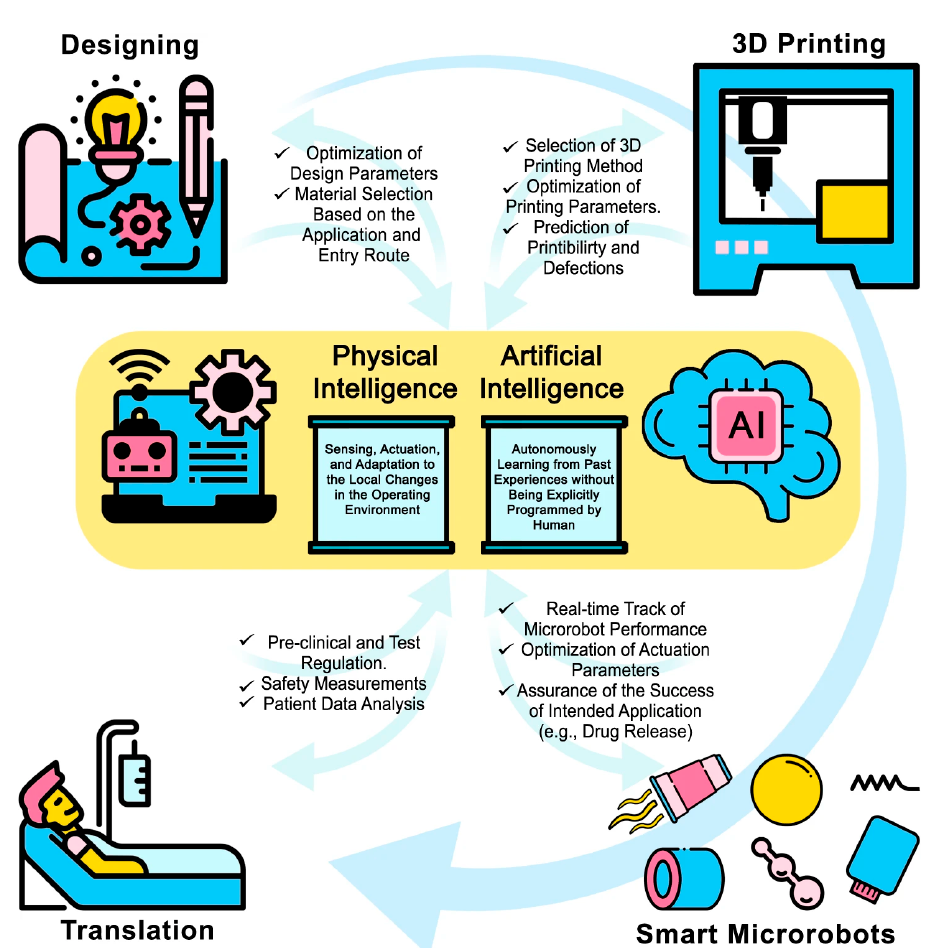
Figure 2. Proposed design of a microrobot. The material selection can be assisted by AI and PI to design a particular device. Artificial intelligence (AI) can help clinicians to track microrobots and enhance maneuverability by tuning actuation parameters to ensure proper functionality, while physical intelligence (PI) enables microrobots to sense different stimuli in their environment and respond to those stimuli independently, for instance, drug release at a particular pH level at the target site. In this regard, test procedures must be regulated to maintain security factors. Reprinted with permission from Ref. [54].